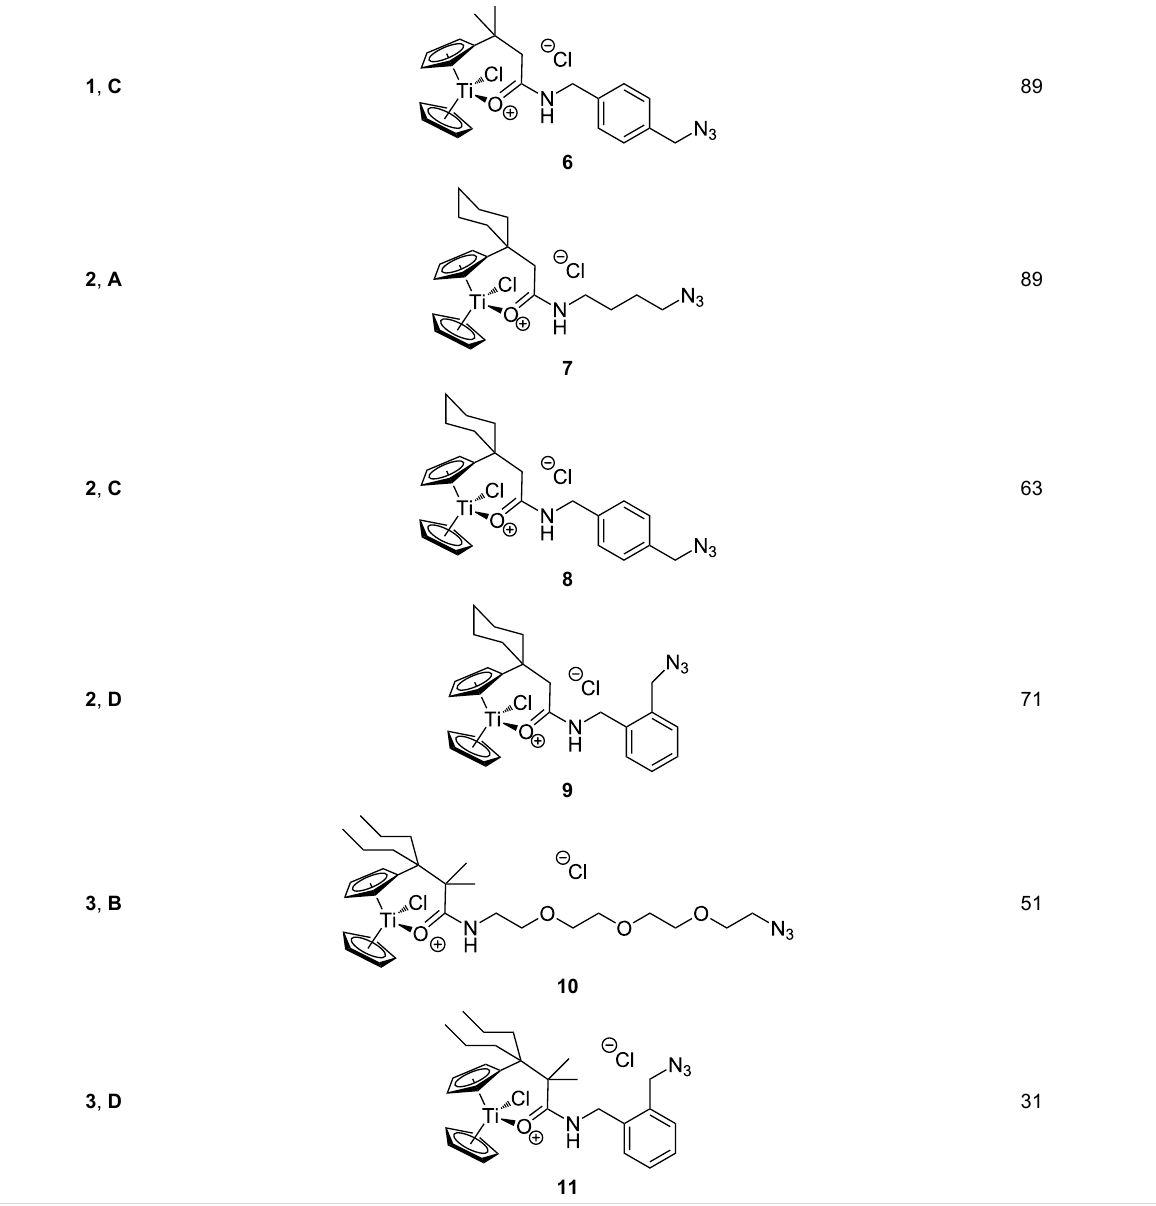
Table 1: Synthesis of cationic titanocenes containing azides (yield over two steps, see Supporting Information File 1 for details).